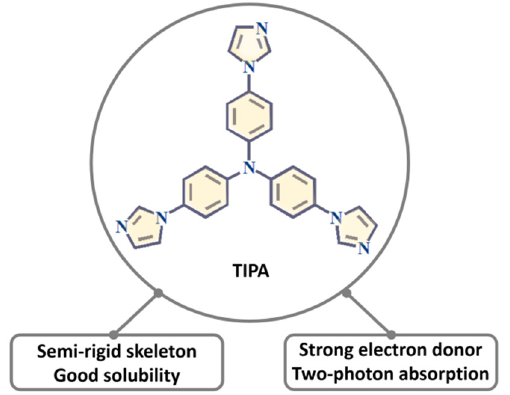
Figure 1. The skeleton and optical properties of TIPA.